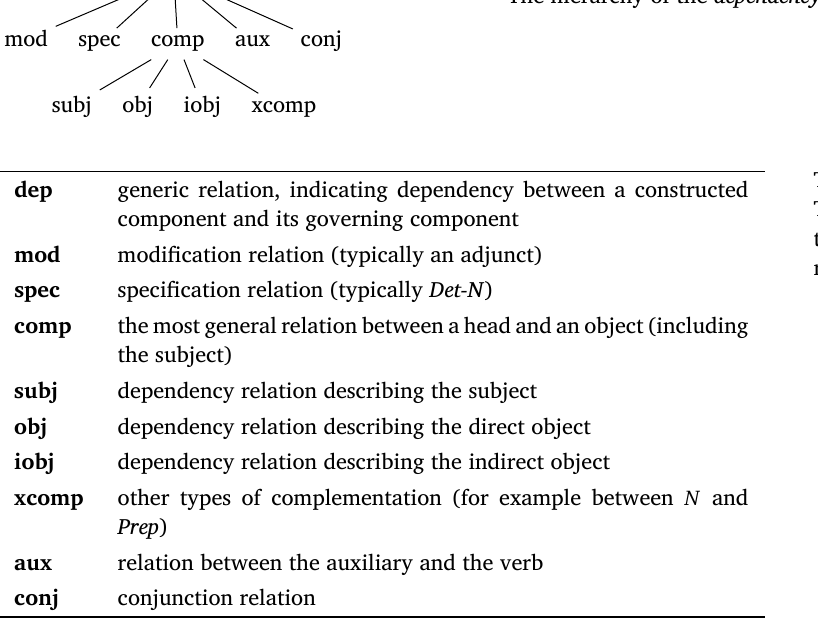
The hierarchy of the dependency